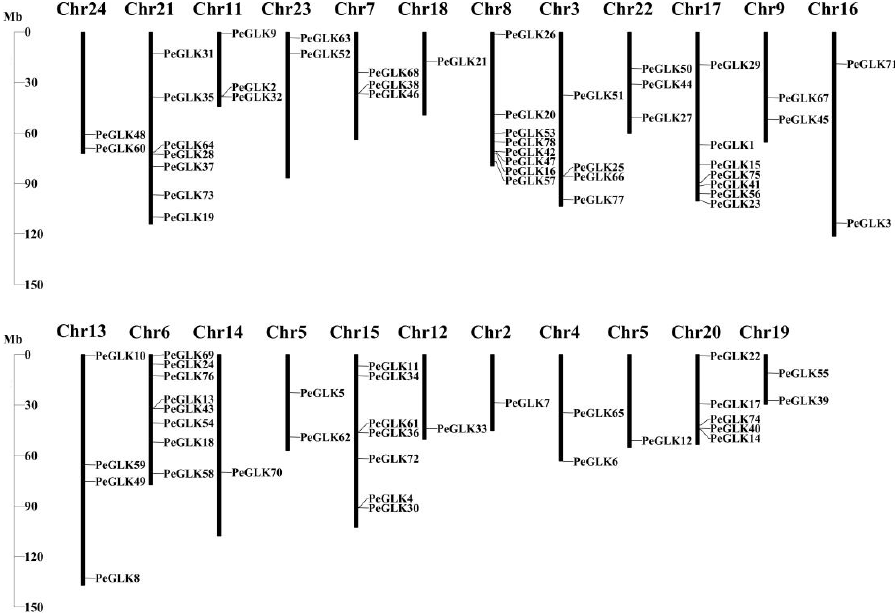
Figure 6. Chromosomal locations of PeGLK genes in Phyllostachys edulis .